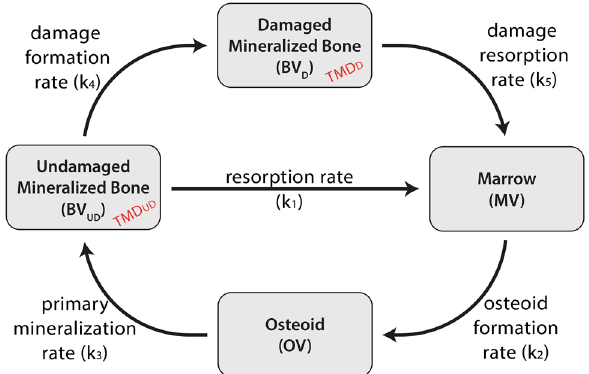
Figure 1. Compartment model of the bone “tissue turnover cycle”. There are four tissue volumes: damaged mineralized bone, undamaged mineralized bone, marrow, and osteoid. Each tissue type is a portion of the total tissue volume (TV) and is defined using histological features. The summation of the four volume compartments is constant, as this compartment model is closed. Tissue volumes can transform following the paths indicated by the arrows at the specified rates ( k i ). Tissue mineral density (TMD) is defined for the undamaged and damaged mineralized bone